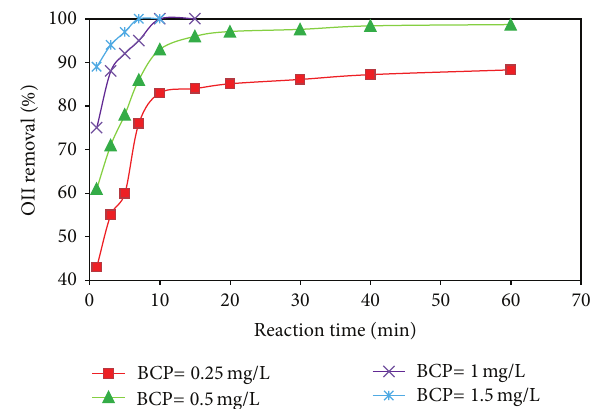
Figure 4: Effect of BCP dosage on OII removal as a function of reaction time (OII concentration 200 mg/L and pH